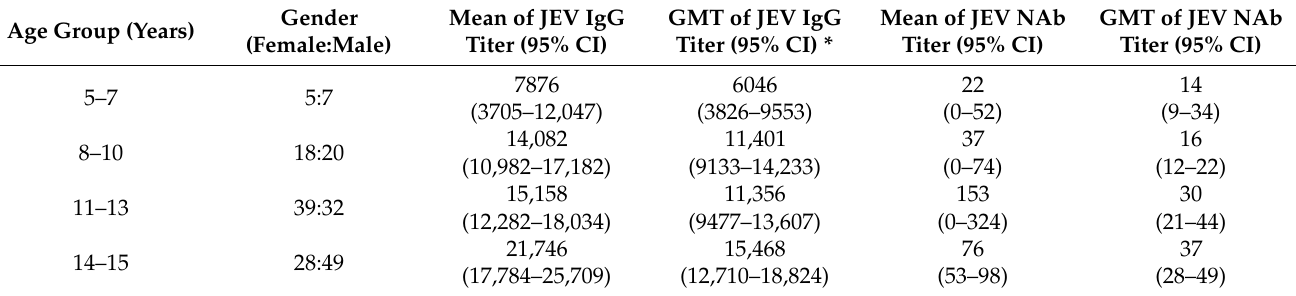
Table 1. Geometric mean titers of Anti-JEV IgG and neutralizing antibodies against